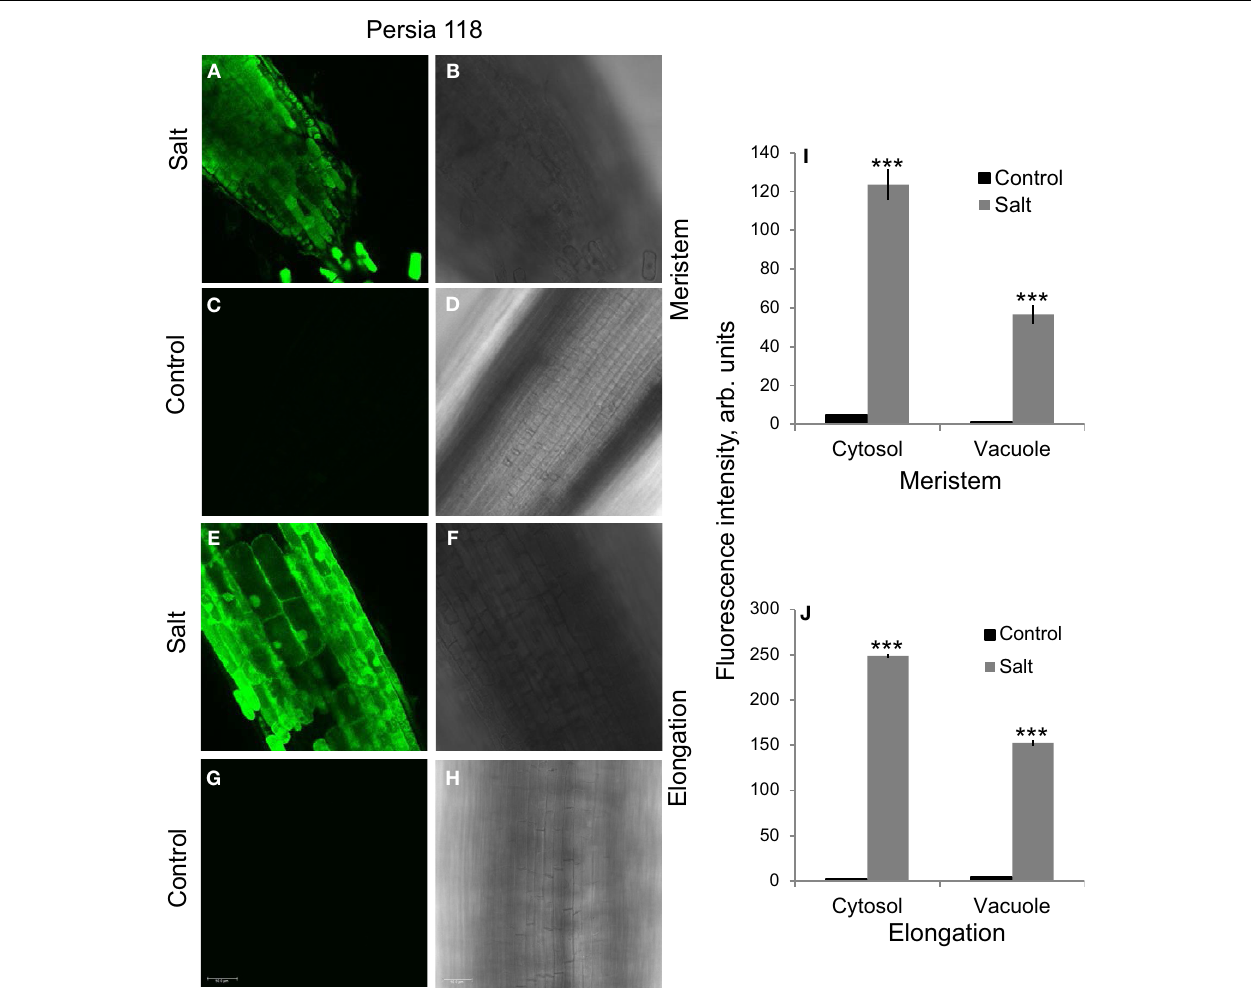
FIGURE 5 | The comparison of Na + fluorescence intensity in salt-grown and Na-free roots. (A,C,E,G) Na + fluorescence intensity was measured in root of Persia 118 cultivar grown in the presence (100mM NaCl for 72h) and absence (milliQ water) of Na + in the growth media. One (of 12)